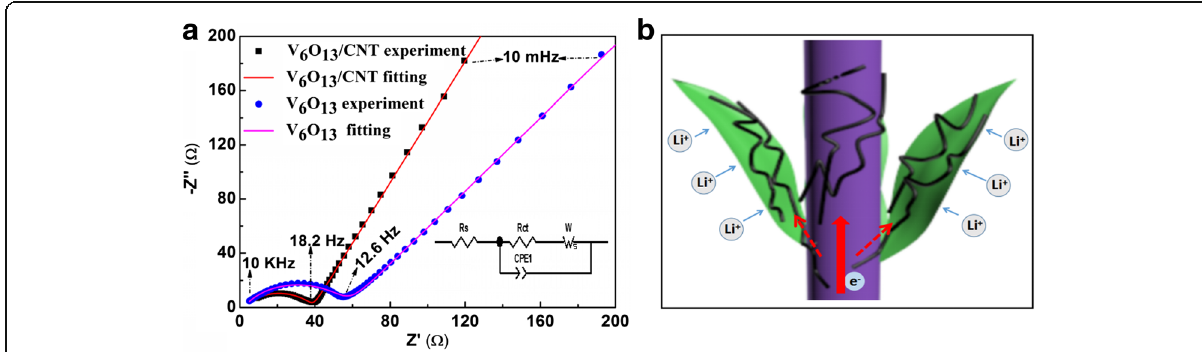
Fig. 6 a Nyquist plots of V 6 O 13 electrode with/without CNT coating. b Schematic of the transporting path for electrons in CNT-coated V 6 O 13